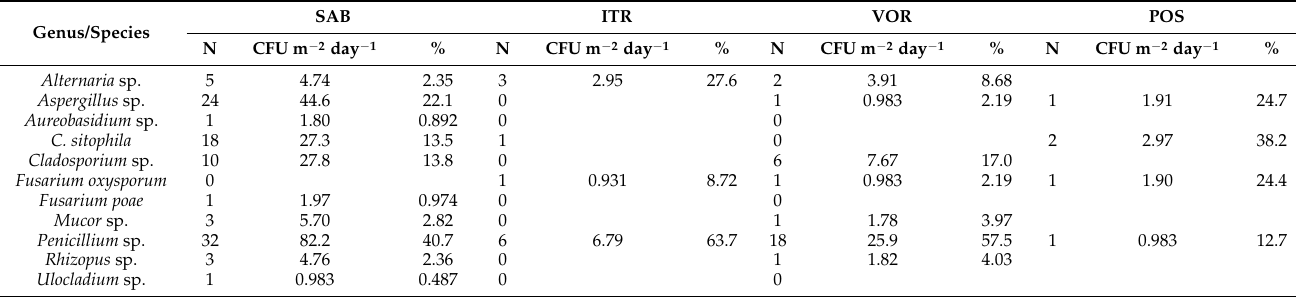
Table 3. Distribution of fungal species through azole screening of electrostatic dust collectors (EDC) samples.